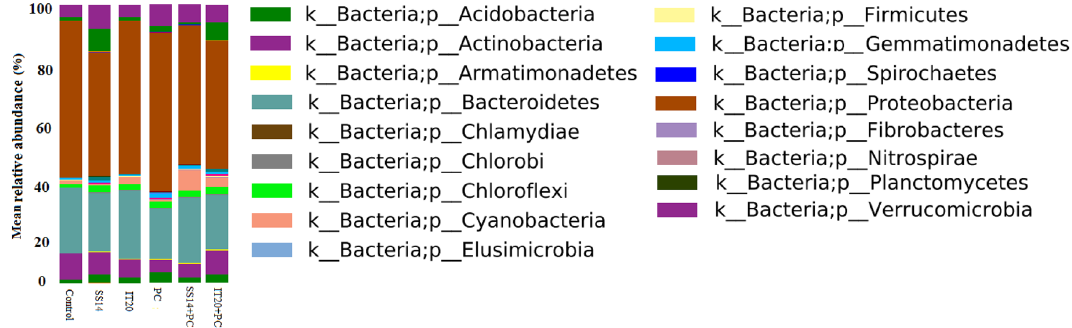
Figure 3. Pepper rhizosphere bacterial community composition in inoculated and non- inoculated samples at the phylum level.